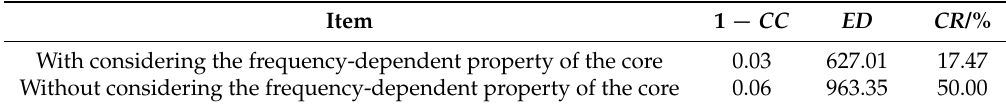
Table 2. Calculation results of numerical indices.